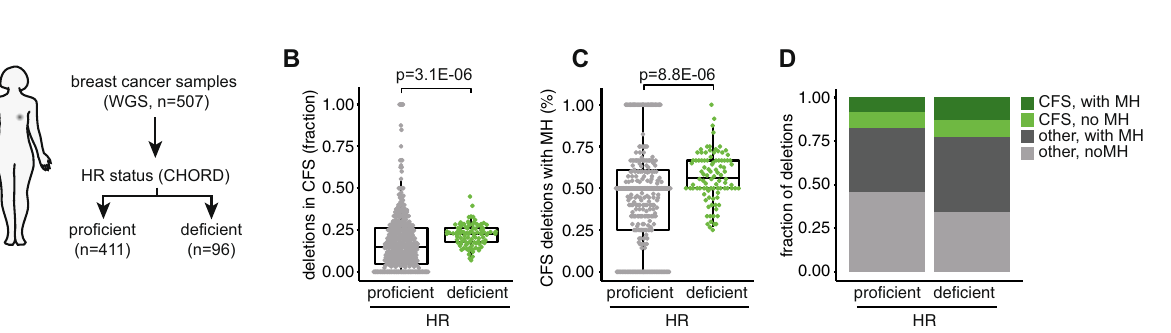
Fig.6|Analysisofgenomicdeletionsatcommonfragilesites.A Whole-genome sequence (WGS) data of n =507 breast cancers of the International Cancer Gen- ome Consortium (ICGC) were analyzed, of which n =96 of which were HRD. HRD status was assessed using the CHORD algorithm. B , C Allelic deletions from 507 breast cancers mapping to common fragile sites were plotted in panel B . Allelic deletions mapping to common fragile sites and having microhomology (MH)